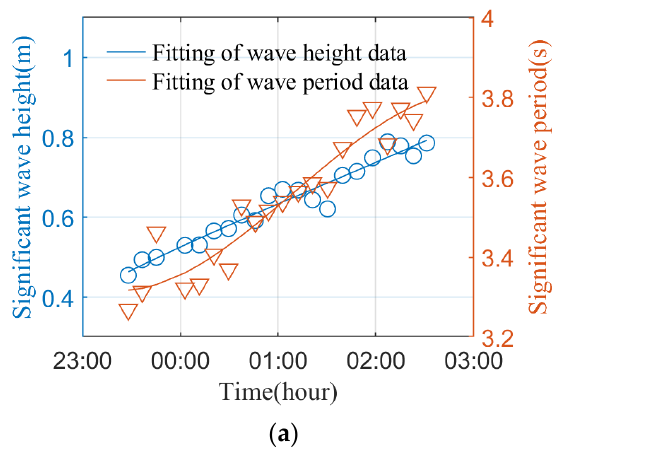
( b ) Figure 21. Simulation results with the specific sea state. ( a ) The x-z view of the wave glider; ( b ) comparison result. Under this specific sea state, the longitudinal average velocities in this study and Rampersadh’s study were, respectively, about 0.41 m/s and 0.4 m/s. 4.2.2. Numerical Simulation Results with Different Current Velocities The wave height of 0.8 m and the wave period of 4.5 s, which are the average values of experimental data in the sea trial area, are the typical sea state input values of this simulation to analyze the impact of current velocity [37]. Figure 22 shows the positions of the surface float in the ξ direction under different current velocities and the same sea state.